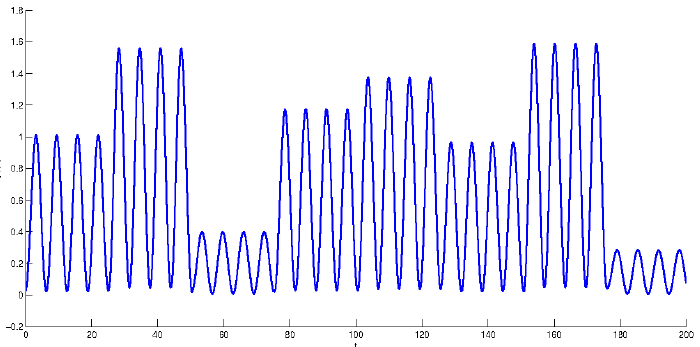
Figure 2. The graph of function f 2 ( t ) with the length of step h = 8 π , and the degree of periodicity ∇ = 0.25.